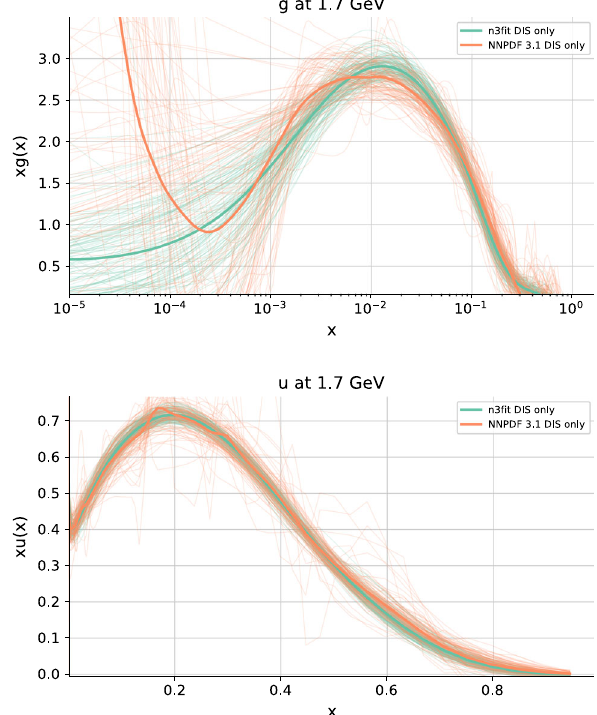
Fig. 6 Comparison of the PDF of the gluon and the u -quark for the DIS only setup. Each line correspond to a different replica while the bold-faced line correspond to the central value of the PDF computed by taking the average of all other